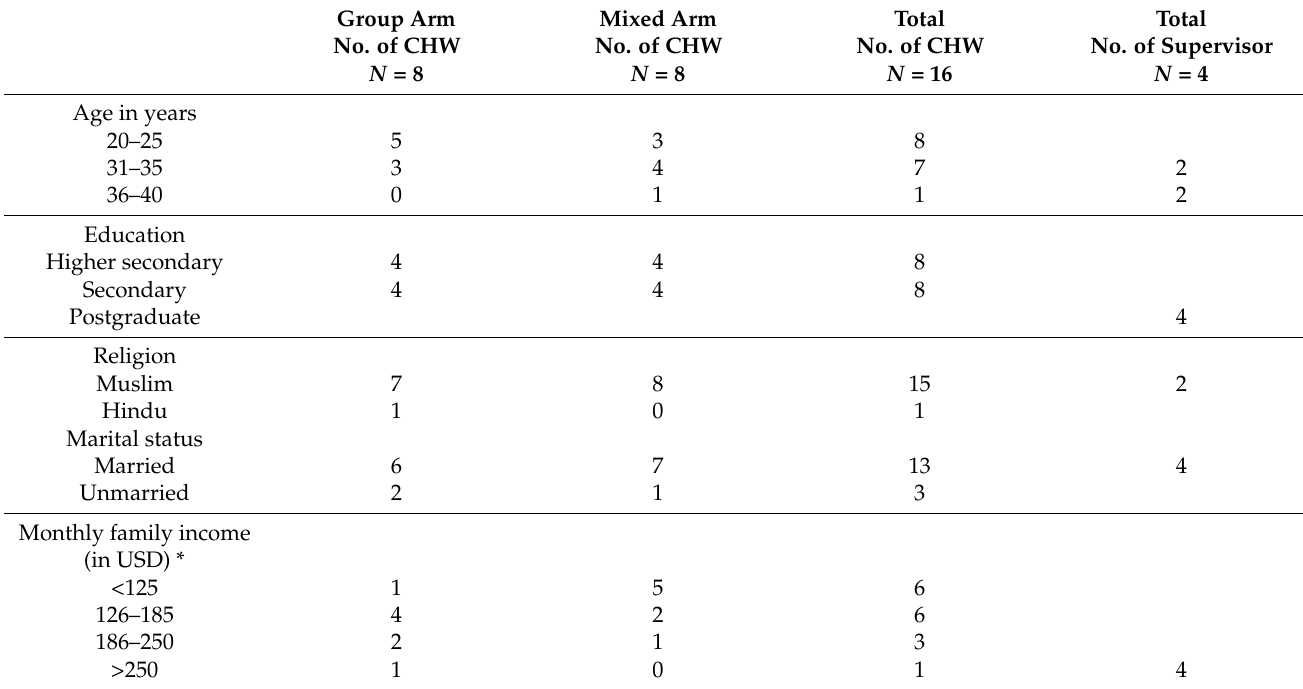
Table 2. Demographic characteristics of CHWs and their